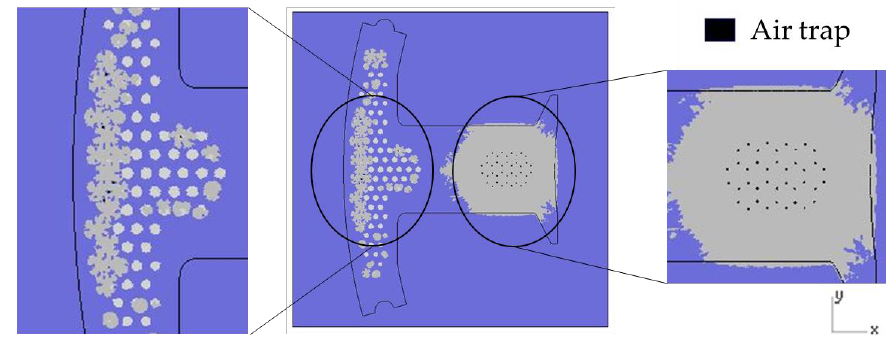
Figure 13. Position of air traps.